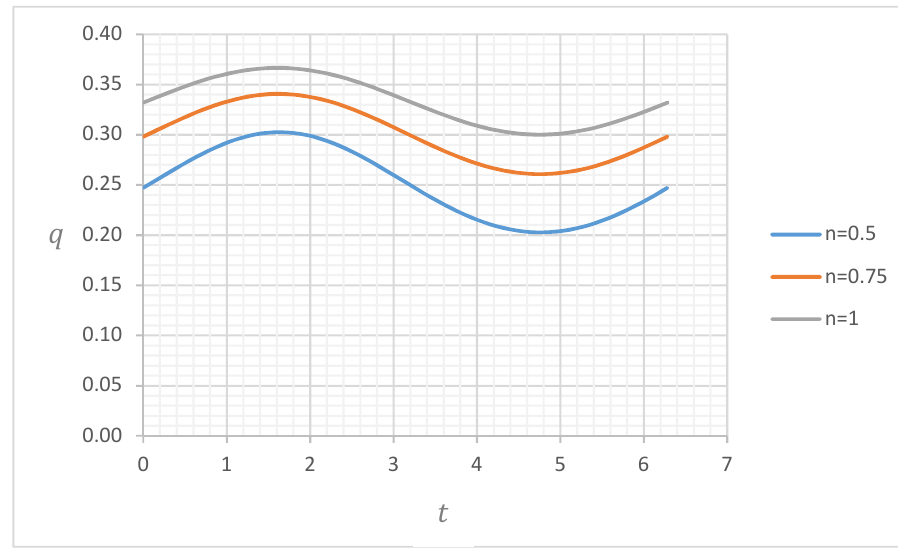
Figure 8. Discharge for = 0.1 , (cid:1844)(cid:1857) = 1 , and (cid:2013) = 0.1 .